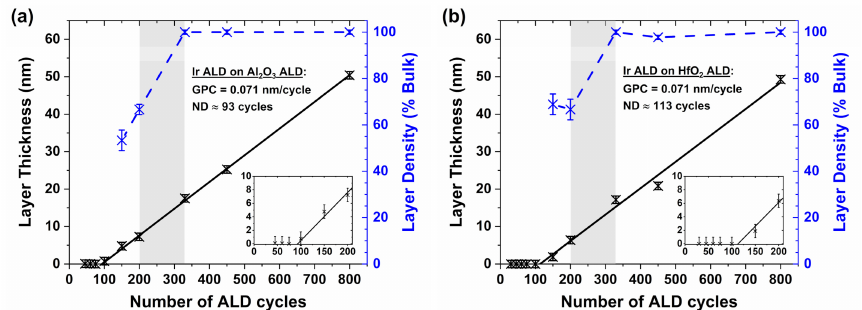
Figure 6. Layer thickness and layer density of Ir coatings depending on the number of ALD cycles on seed layers of ( a ) Al 2 O 3 and ( b ) HfO 2 . The film growth is fitted linear (black lines), and the corre- sponding GPC and ND are indicated. A gray background highlights the region of Ir layer percolation.